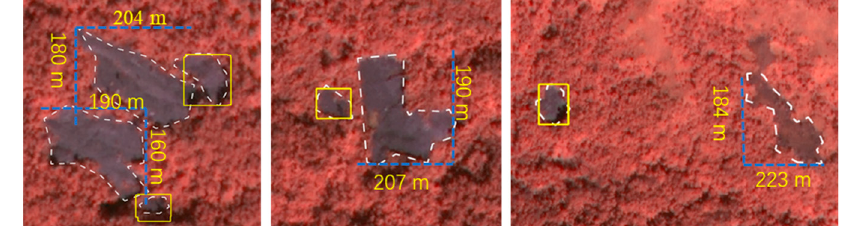
Figure 17. An example of poor performance of the model with large parcels: the yellow rectangle boxes are prediction results, the white polygons are ground truth poppy parcels; some bigger parcels are not detected.